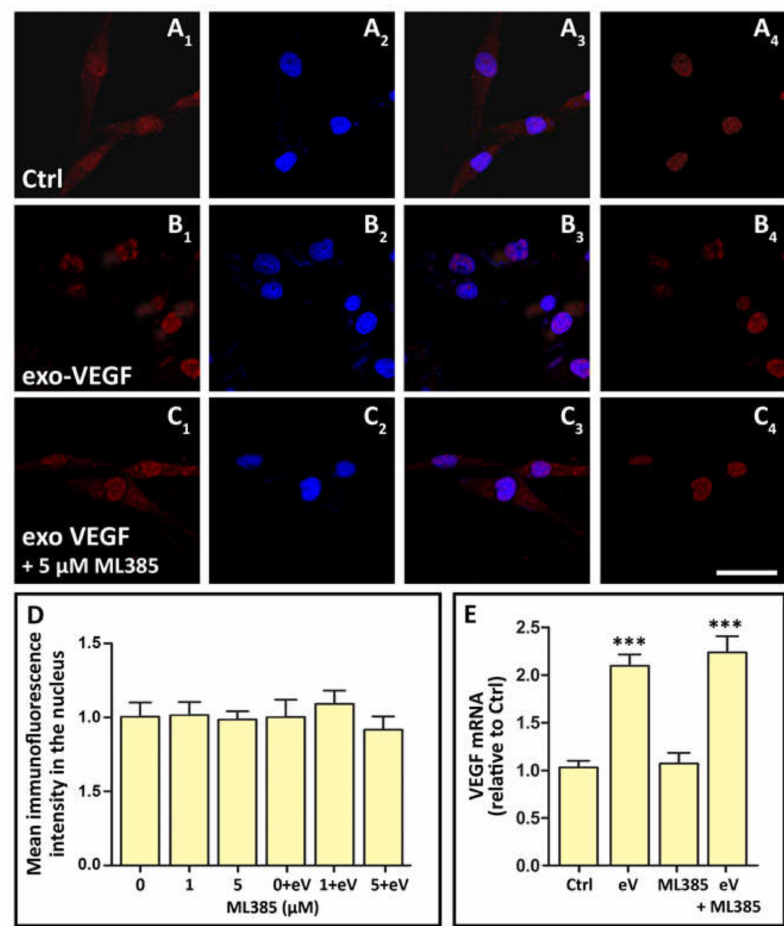
Figure 6. Immunofluorescence images documenting Nrf2 production and nuclear translocation in Ctrl, in exo-VEGF-treated and in exo-VEGF-treated MIO-M1 cells incubated in the presence of the Nrf2 inhibitor ML385 (exo-VEGF + ML385). ( A1 ), ( B1 ) and ( C1 ) show the overall Nrf2 immunostaining of MIO-M1 cells in the three di ff erent conditions; ( A2 ), ( B2 ) and ( C2 ) show the Hoechst-stained cell nuclei; ( A3 ), ( B3 ) and ( C3 ) are merged images of the previous two; ( A4 ), ( B4 ) and ( C4 ) show Nrf2 immunostaining limited to the cell nucleus. Scale bar, 50 µ m. The histograms in ( D ) represent the quantification of immunofluorescence intensity within the nuclei of MIO-M1 cells in the di ff erent experimental conditions. The values are relative to that corresponding to 0 µ M ML385; eV, exo-VEGF. The histograms in ( E ) represent VEGF mRNA expression in MIO-M1 cells exposed to exo-VEGF (eV) for 24 h and e ff ect of the Nrf2 inhibitor ML385. *** p < 0.001 relative to Ctrl. n = 4 in ( D ); n = 3 in ( E